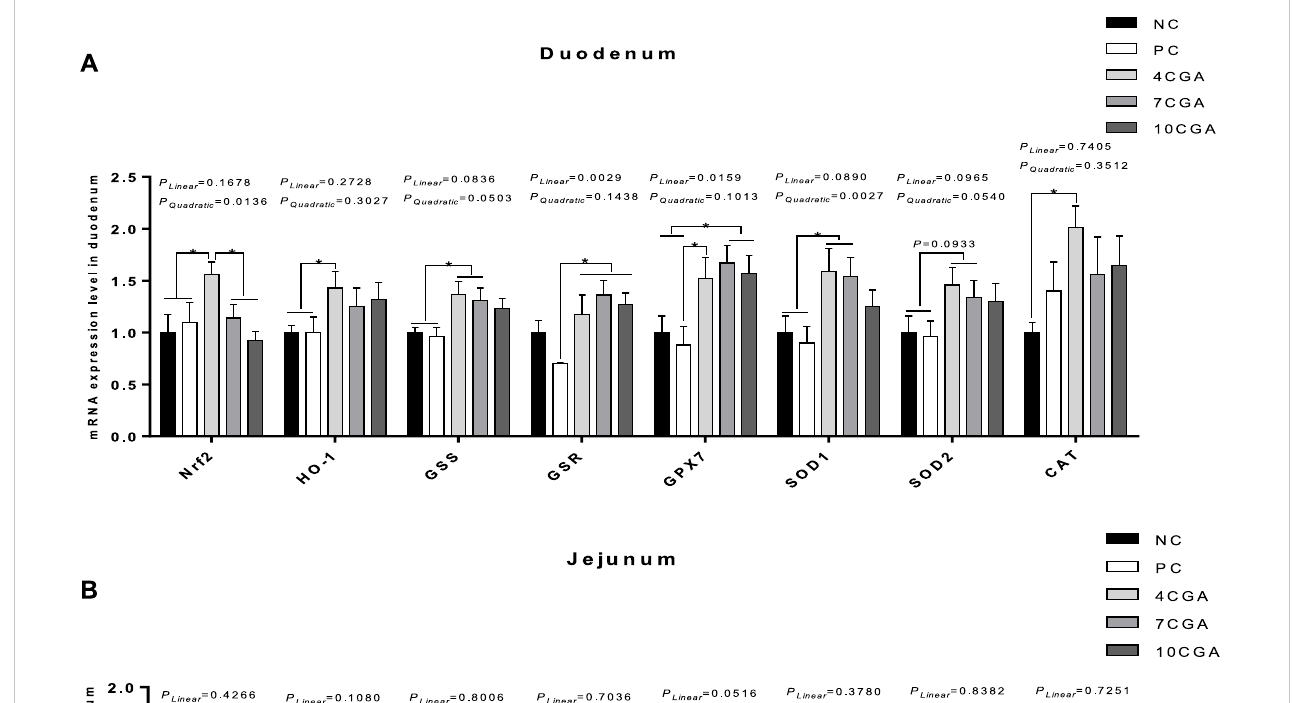
FIGURE 5 Effects of in ovo feeding of chlorogenic acid on mRNA expression of antioxidant-related genes of 42 d-heat stressed broilers. (A) Duodenum; (B) Jejunum; (C) Ileum. * indicates a signi fi cant difference between treatments ( p < 0.05), n = 6.